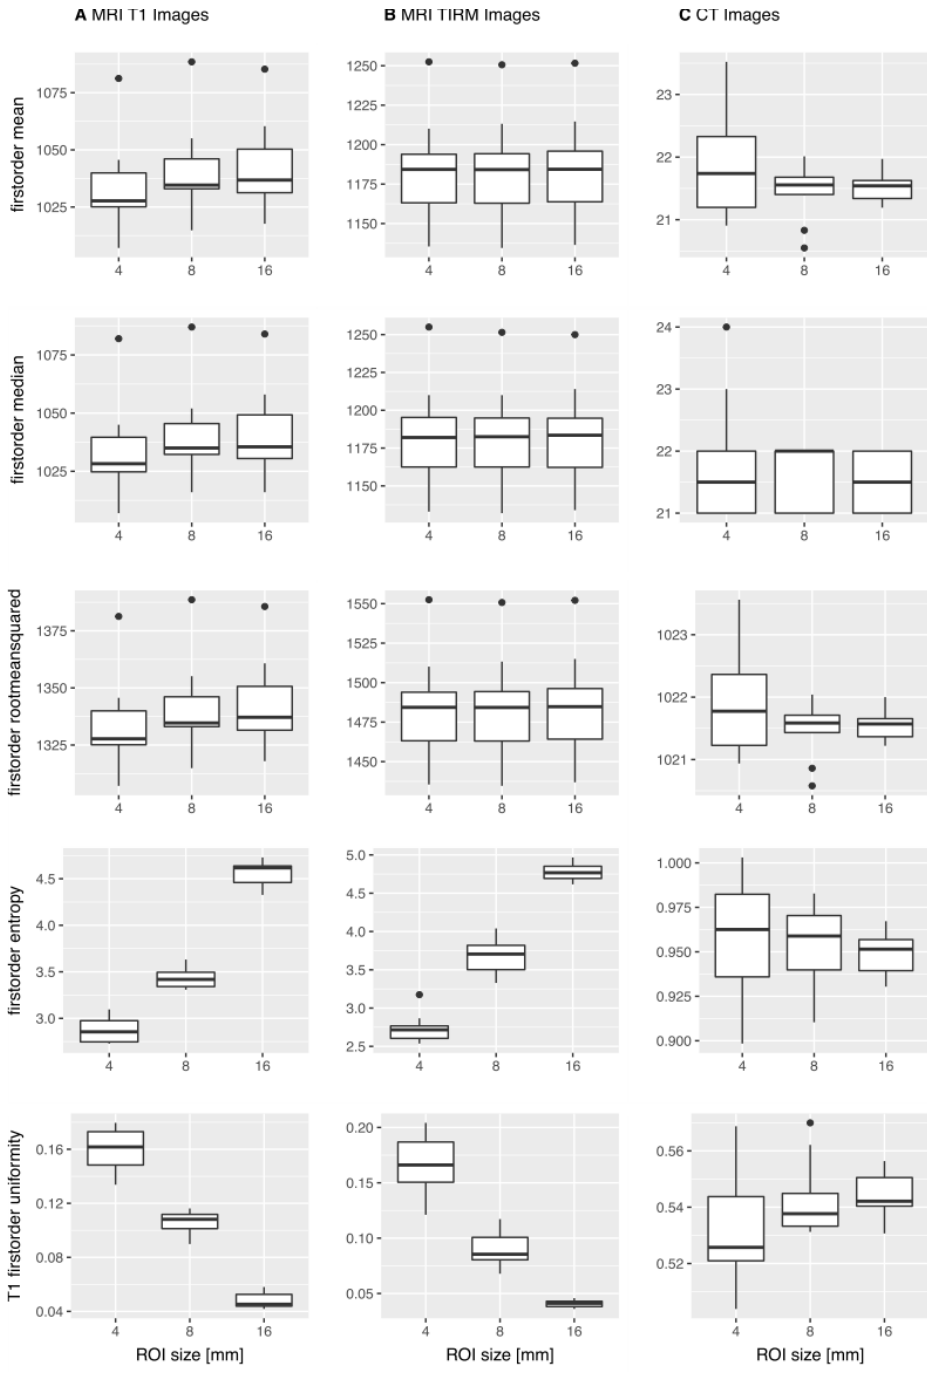
Figure 3. Exemplary boxplots of first-order features mean, median, root mean squared, entropy, and uniformity across the 10 repetitive scans. For the T1w MR images ( A ) and the T2w TIRM MR images ( B ), mean, median, and RMS showed no significant difference in the Mann–Whitney U-test, whereas entropy and uniformity were significantly different. For the CT images ( C ), the illustrated features did not show significantly different results, i.e., the features do not simulate significant differences.